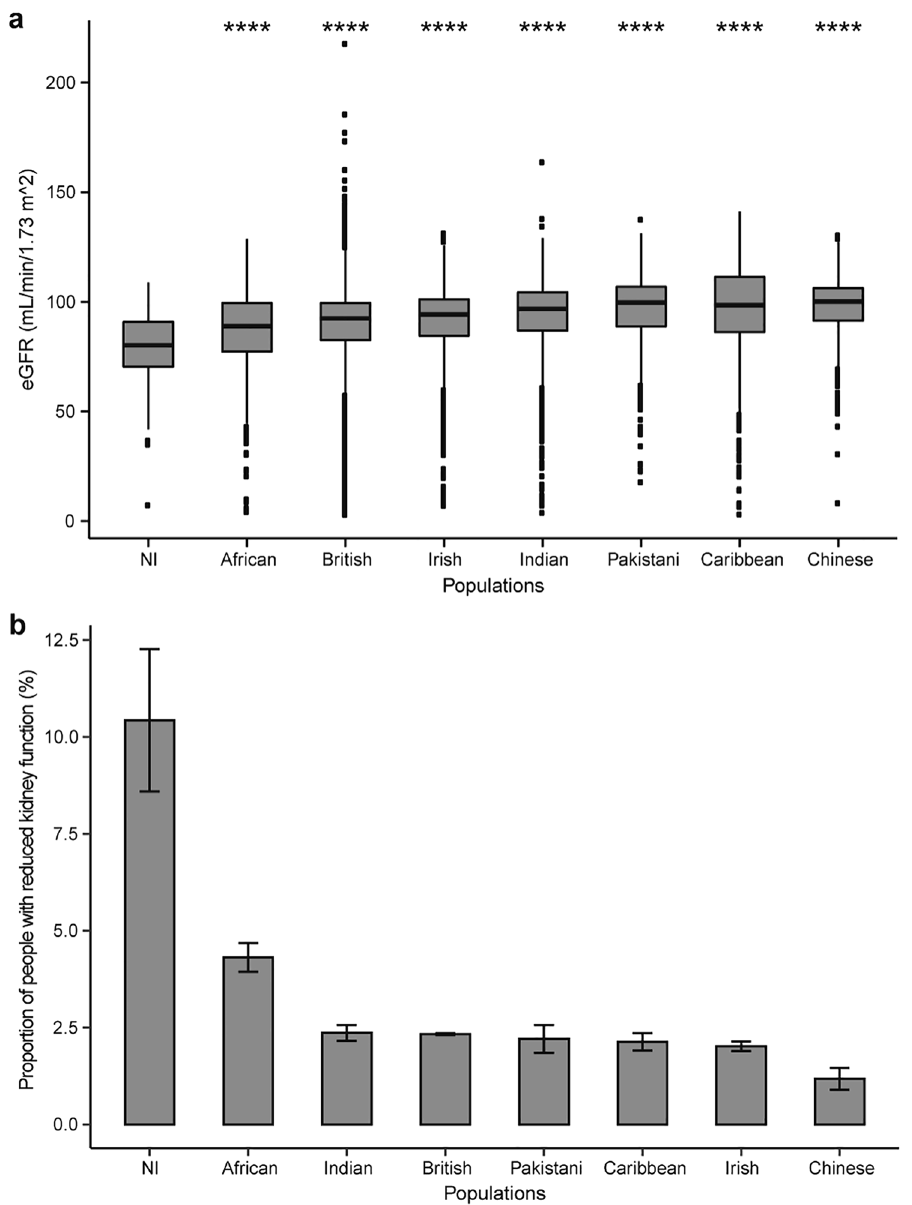
Figure 1. Comparison of eGFR in NI isolate to those of other populations. ( a ) Distributions of eGFR in NI isolate and other populations. There were statistically significant differences between mean of eGFR in NI compared to those of other population (adjusted P-values < 2e−13). ( b ) Proportion of people with reduced kidney function (eGFR < 60 mL/min/1.73 m 2 ) in each population. Data are represented as the percentage ± SE.